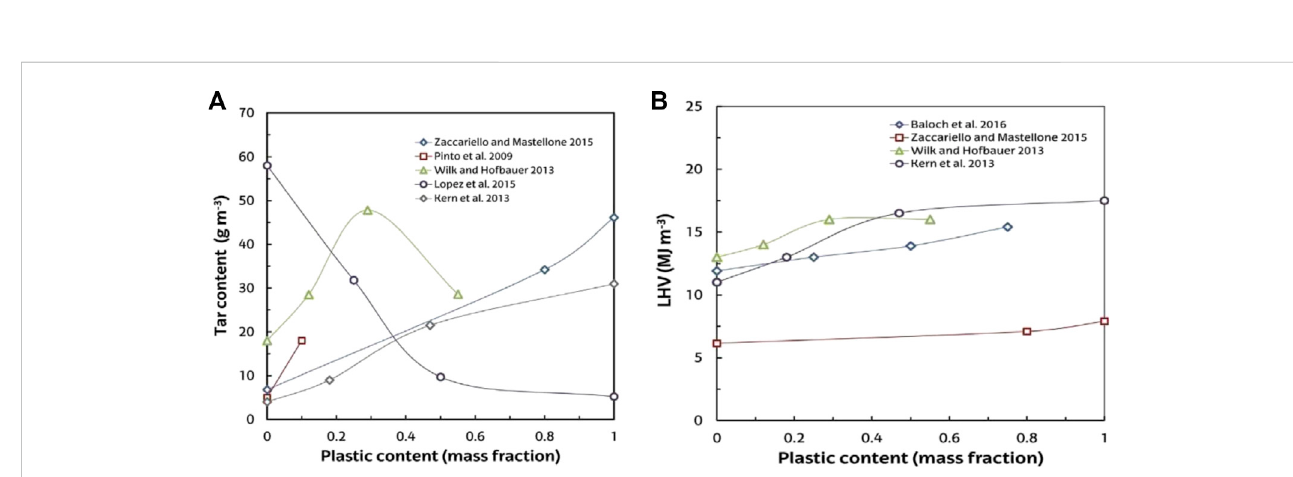
FIGURE 10 (A) Plastic content effect in the feed on the content of tar in theproduced gas in plastics co-gasi fi cation with coal and biomass. (B) Plastic contenteffect in the feed on the produced gas heating value in plastics co-gasi fi cation with coal and